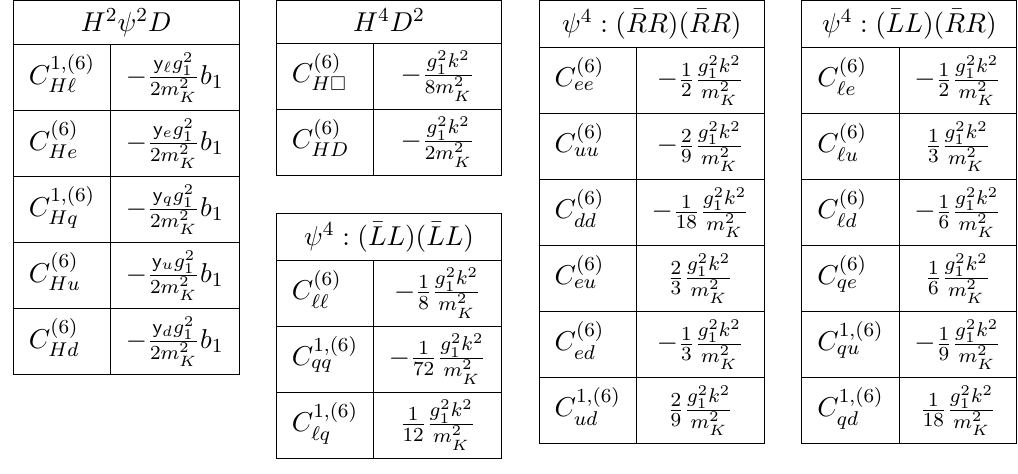
Table 8 . L (6) matching coefficients in the U(1) model [16], here b 1 = k 2 − 2 λ ( k 2 − k 4 ) ¯ v notation is such that y i is the hypercharge of field i .